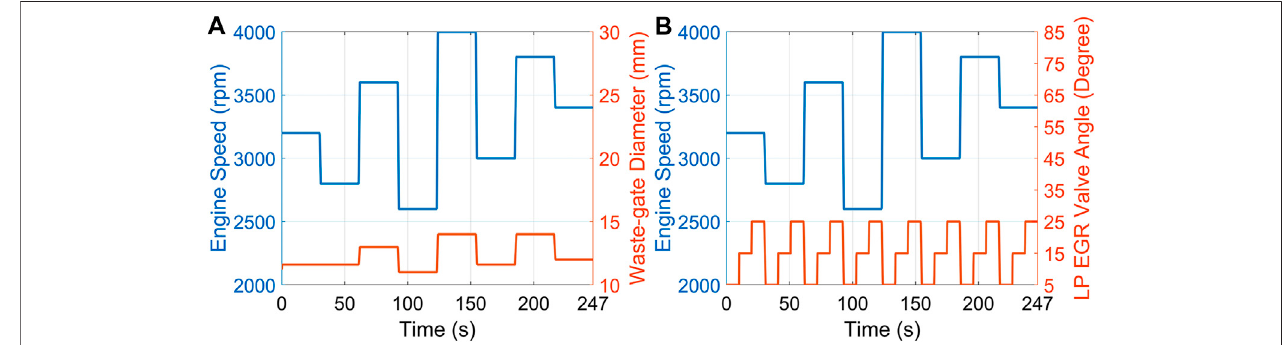
FIGURE 3 | Engine operation conditions (A) : engine speed and waste-gate (B) : engine speed and LP EGR valve.